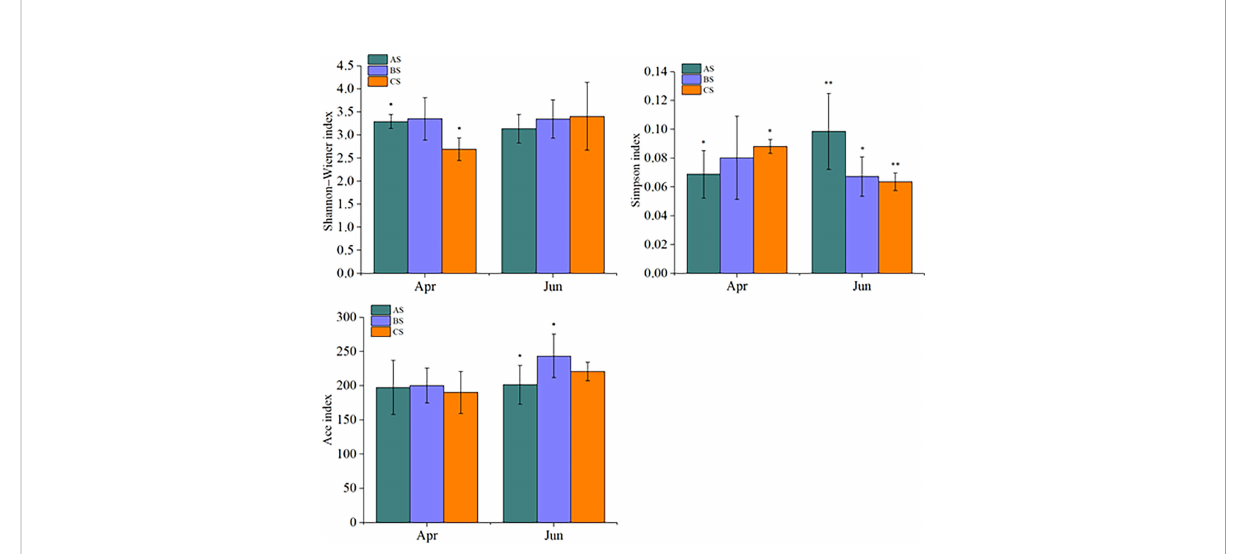
FIGURE 4 Shannon-Wiener, Simpson, and Ace alpha diversity index values for AS, BS, and CS communities. Note AS: surface samples from culture area BS: surface samples from Adjacent area CS: surface samples from control area,"*" and "**" indicates that BS or CS have signi fi cant differences compared with AS (*p <0.05, **p<0.01, one-way